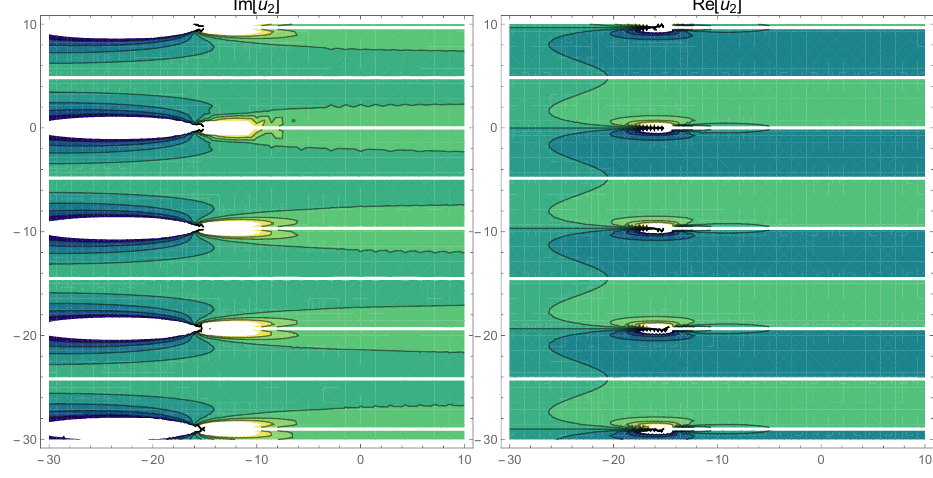
Figure 5. The contour figures of Equation (14).